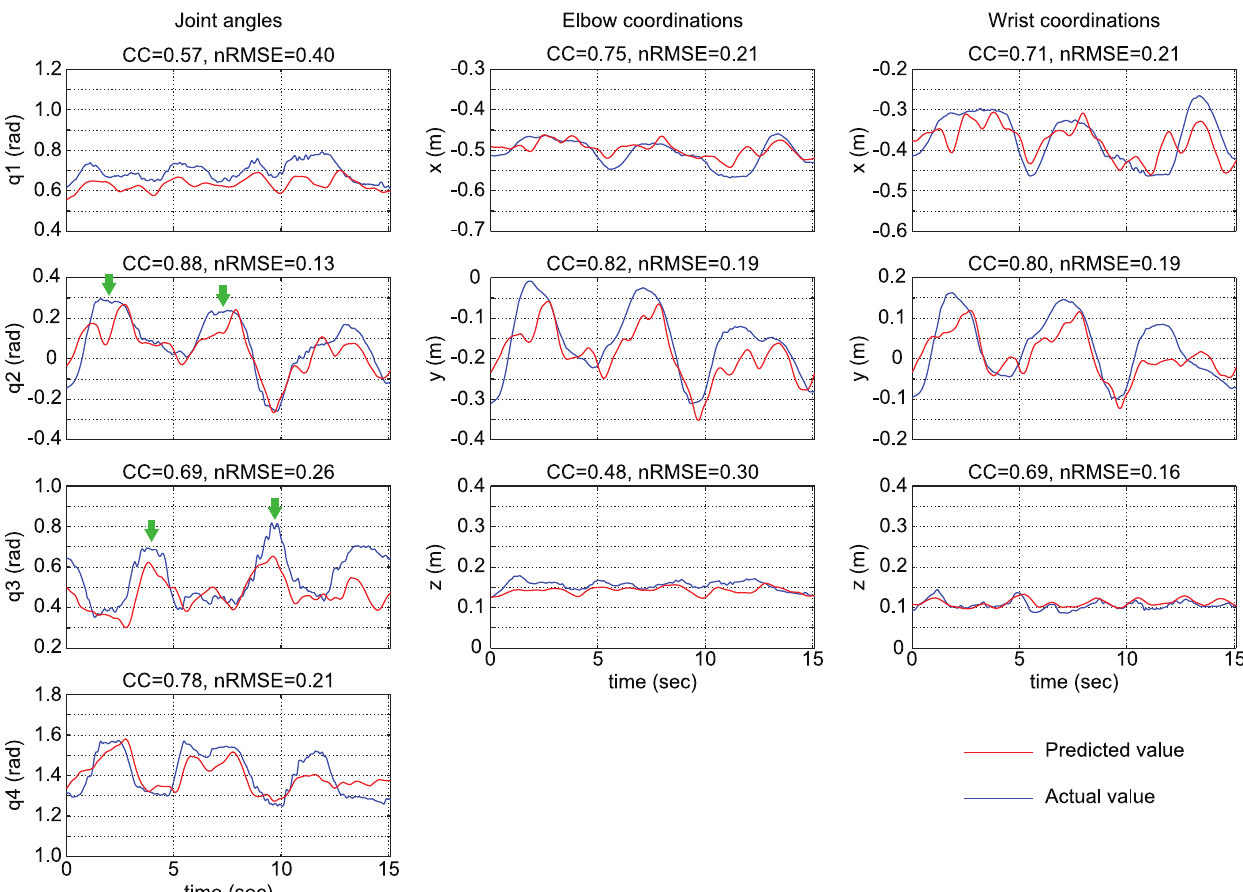
Figure 6. Examples of predicted joint angles and positions in time series. Blue lines are actual recoded joint angles (left column), and actual positions at the left elbow (center column) and left wrist joint (right column) in the 10th trial shown in Figure 3 and Figure 4. The joint angles and coordinates predicted with sparse linear regression are plotted in red. The Pearson’s correlation coefficient (CC) and the normalized root-mean-square error (nRMSE) are shown at the top of each graph.